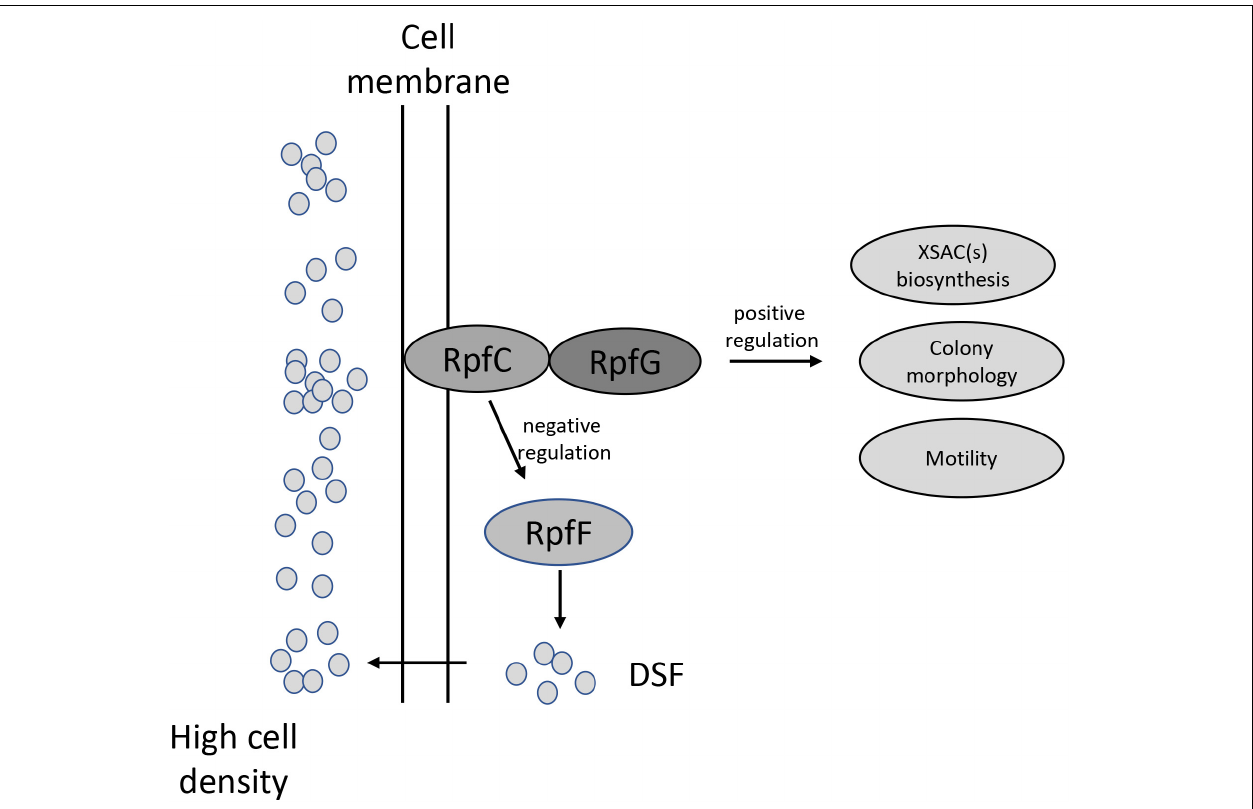
FIGURE 6 | Schematic model of the DSF quorum-sensing system in L. brunescens . Lb DSF biosynthesis was found to be linked to RpfF (enoyl-CoA hydratase) and was dependent on the two-component regulatory system RpfC (hybrid sensor histidine kinase)/RpfG (response regulator). Lb DSF positively regulates XSAC biosynthesis, surface motility, and cell